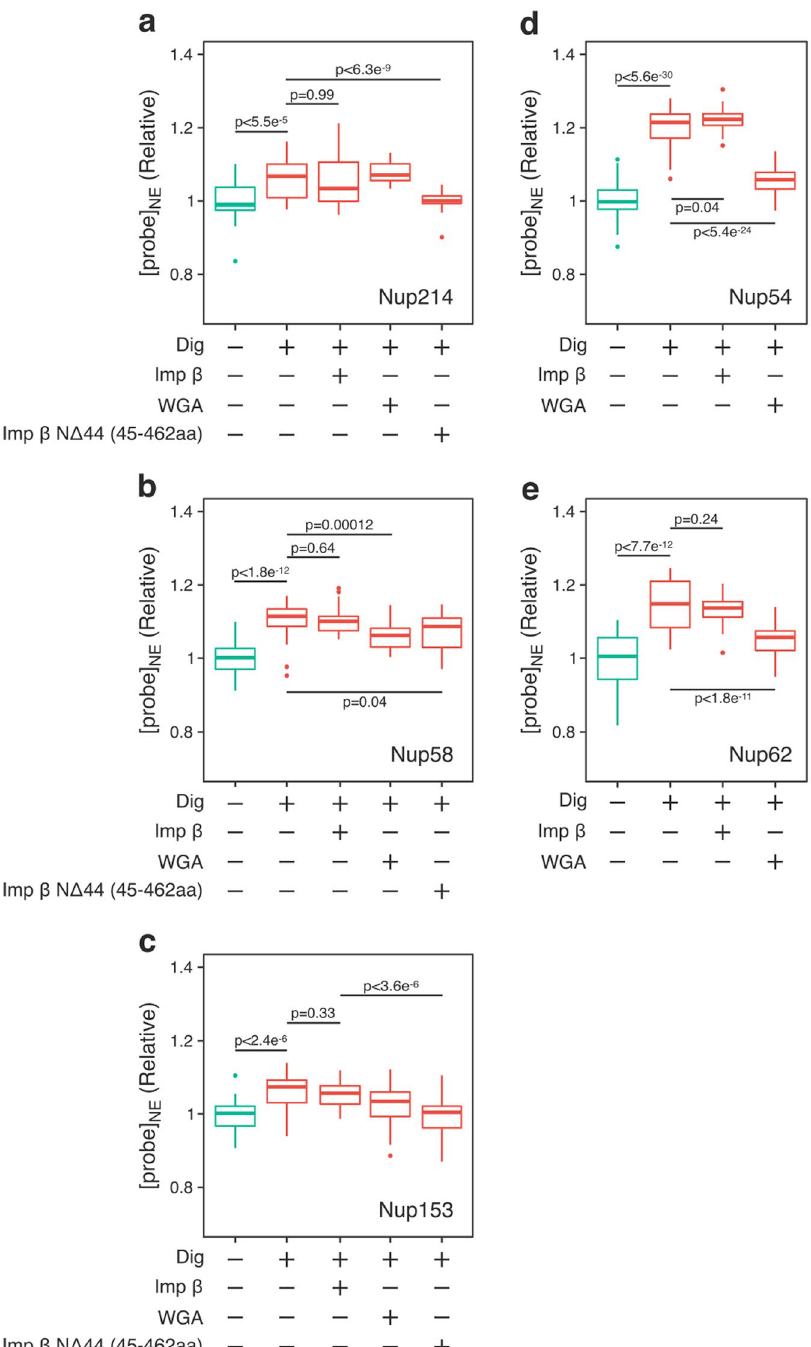
Figure 3. Transport inhibitors affect protein crowding in the NPC. HeLa cells expressing GimRET-fused Nups (214 ( a ), 58 ( b ), 153 ( c ), 54 ( d ) and 62 ( e )) were treated with digitonin (Dig), followed by wild type of importin β (10 μ M), wheat germ agglutinin (WGA, 50 μ g/mL) or a fragment of importin β (Imp β N ∆ 44, 45–462aa, 10 μ M). The probe signal in the nuclear envelope ([probe] NE ) after each treatment was analyzed and shown as the relative value to the probe signal of intact cells. Data are presented as 25% and 75% quartiles; median, bold line; outliers, ○ , from over 30 different cells. P-values are obtained from two-tailed Welch’s